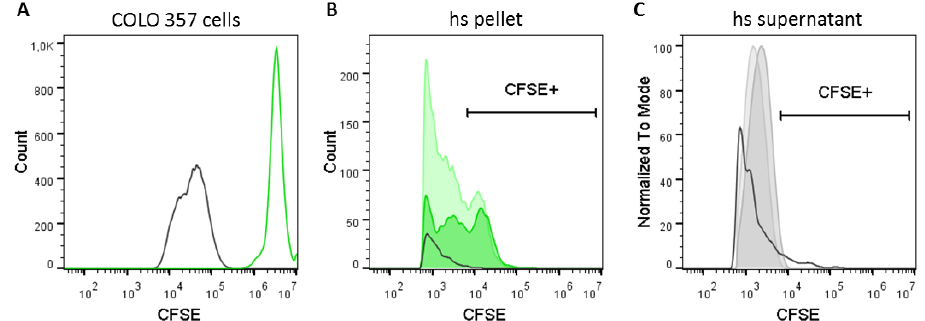
Figure 5. Tracking of ectosome shedding by CFSE-labeling of cells. COLO 357 cells were fluorescently labeled with CFSE and cultivated under standard cell culture conditions for 48 h. Cell culture supernatants were harvested 24 and 48 h after seeding, and cells were detached and collected from their surface 48 h after seeding. The presence of CFSE + signals was determined ( A ) in cells after 48 h of cell culture as well as in ( B ) the pellet and ( C ) the supernatant after high-speed centrifugation (10,000 × g ) by flow cytometry. Samples were measured with a threshold of 600 for the FITC channel. Black line histogram = unstained control; green line histogram = CFSE-labeled COLO 357 cells; dark green filled histogram = hs pellet 24 h after seeding; light green filled histogram = hs pellet 48 h after seeding; dark grey filled histogram = supernatant 24 h after seeding; light grey filled histogram = hs supernatant 48 h after seeding. The CFSE + gate was set according to the EV-dependent signal from a directly labeled hsEV preparation (see Figure 3E).